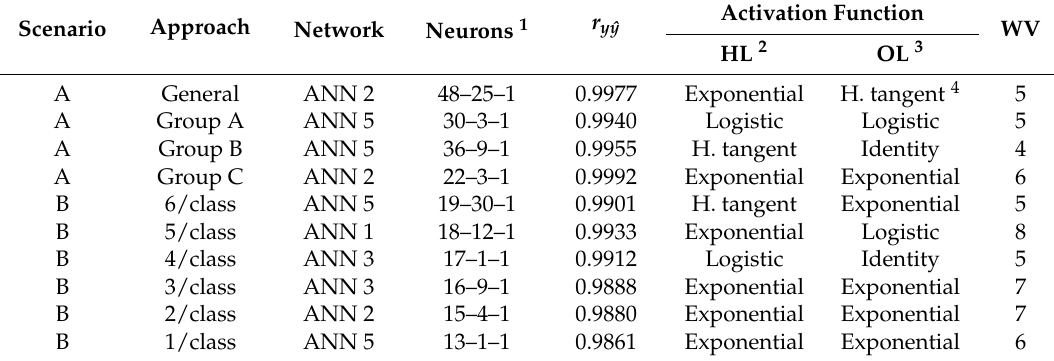
Table 4. Configurations, correlation coefficients between real and predicted values ( r yˆy ), and weighted value (WV) of the best artificial neural network in the generalization of the approaches in scenarios (a) and (b).